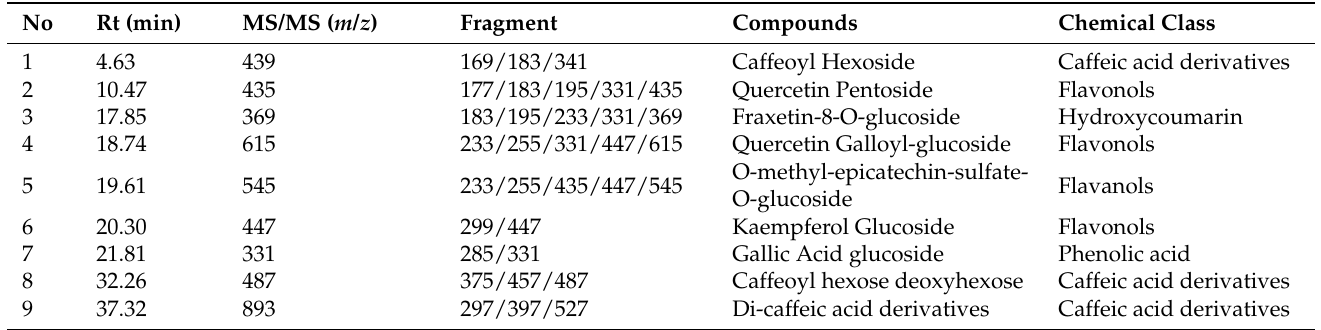
Table 2. Identification of main phenolic compounds of J. regia bark extracts using HPLC-DAD-ESI- MS/MS.